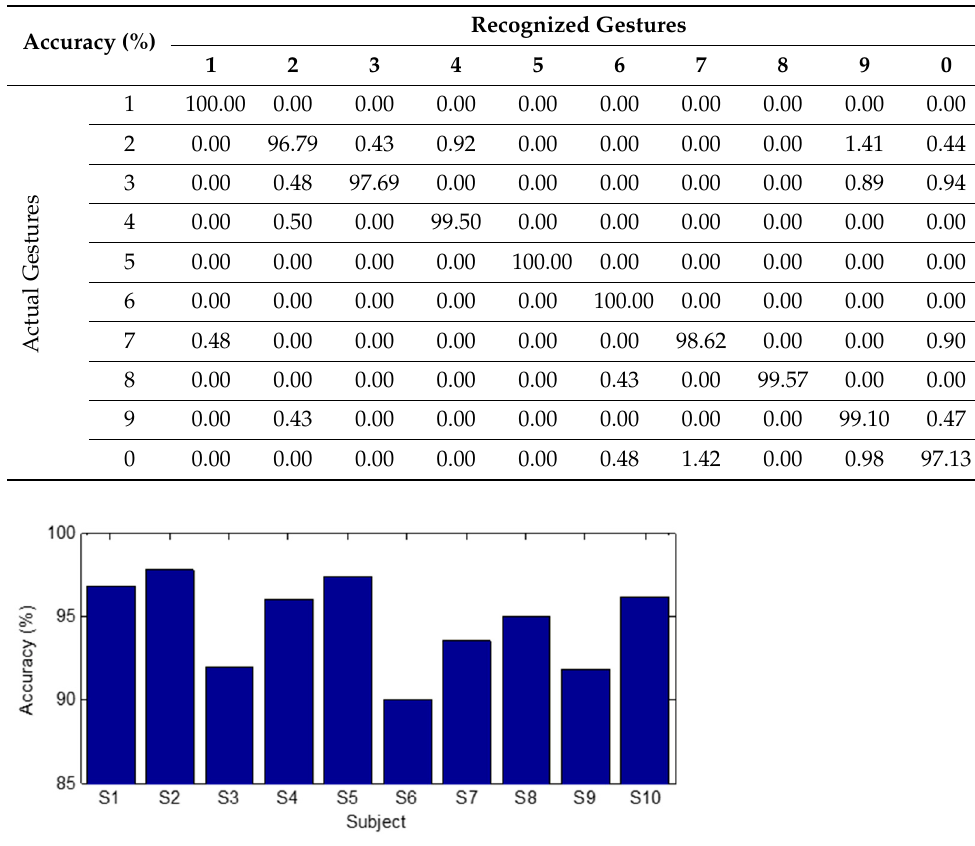
Figure 22. Results of Test B in digital gesture recognition experiment.